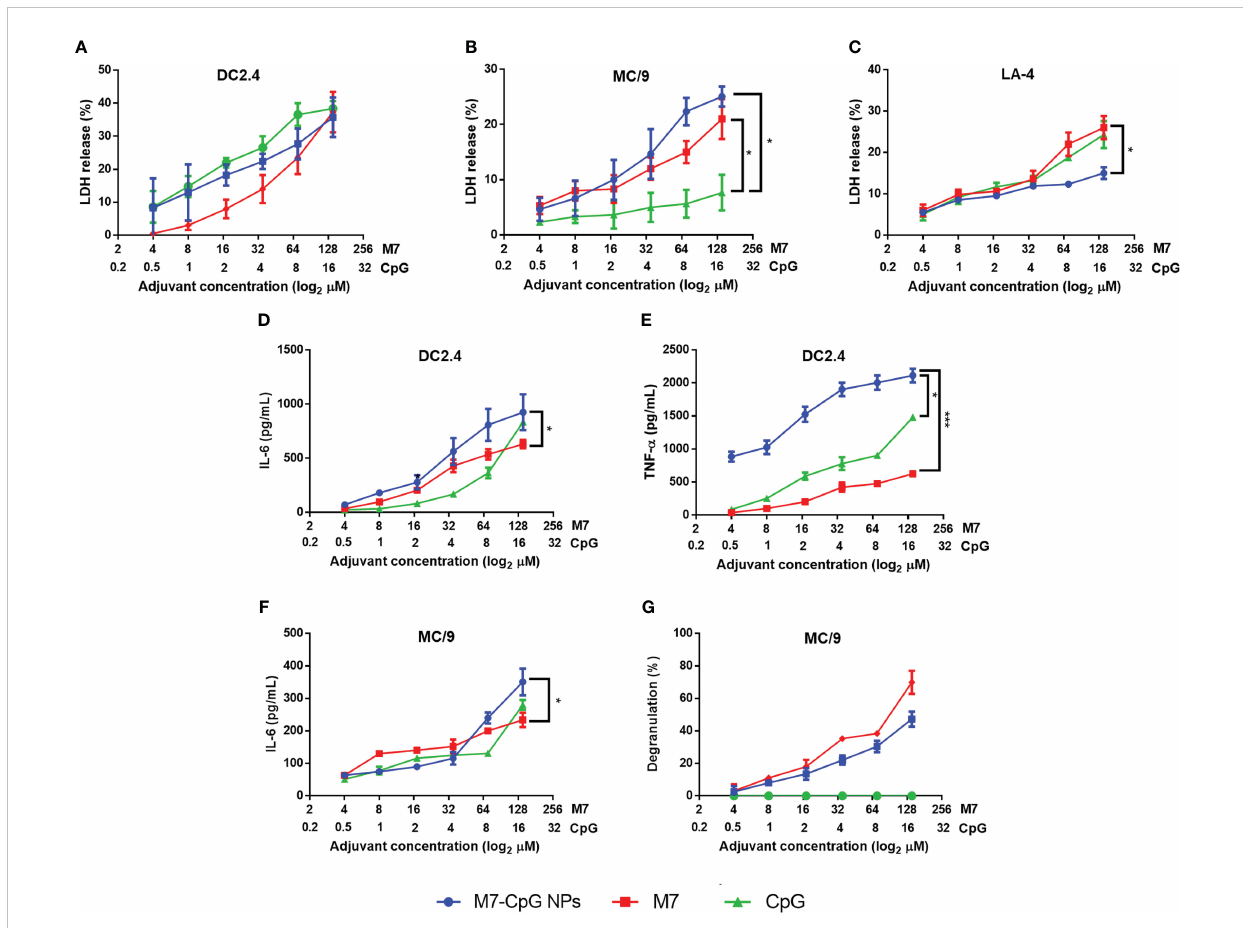
FIGURE 3 M7-CpG NPs decrease cytotoxicity and increase innate immune response in vitro . (A) DC2.4 cells, (B) MC/9 cells, and (C) LA-4 cells were stimulated with M7, CpG, or M7-CpG NPs and cytotoxicity was measured by LDH release at 48 h post-stimulation. (D) IL-6 and (E) TNF- a expression was evaluated in culture supernatants from DC2.4 cells stimulated with the same conditions at 48 h post-stimulation. (F) IL-6 expression and (G) degranulation levels in supernatants were evaluated in MC/9 cells stimulated with the same conditions at 30 min and 48 h post-stimulation, respectively. Data are presented as mean ± range ( n = 6, two independent experiments). Signi fi cant differences were determined using a two-way ANOVA test with Tukey ’ s multiple comparison (* p ≤ 0.05; *** p ≤